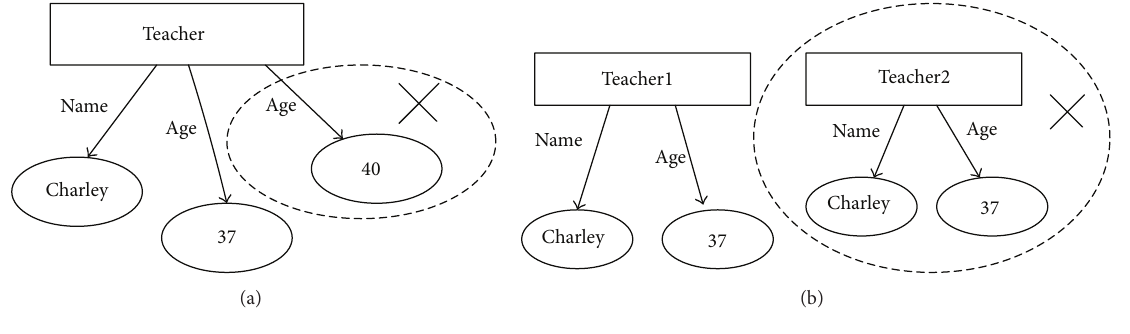
Figure 5: A fact